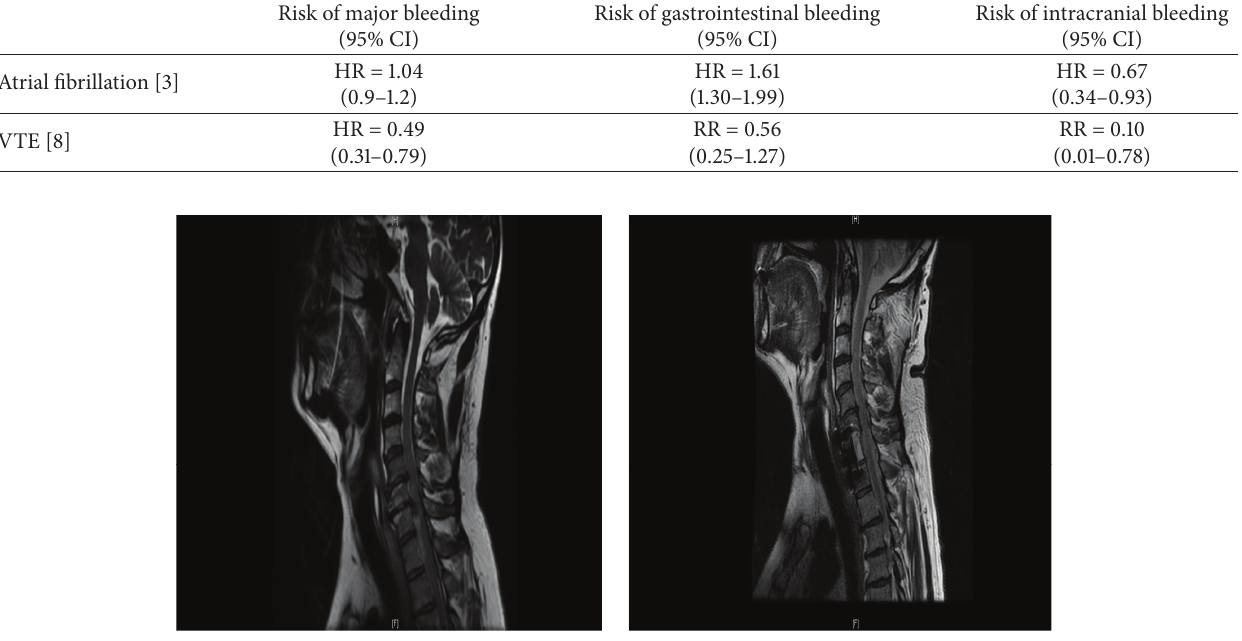
Table 2: Risks of rivaroxaban-associated major bleeding events compared to warfarin in selected studies.